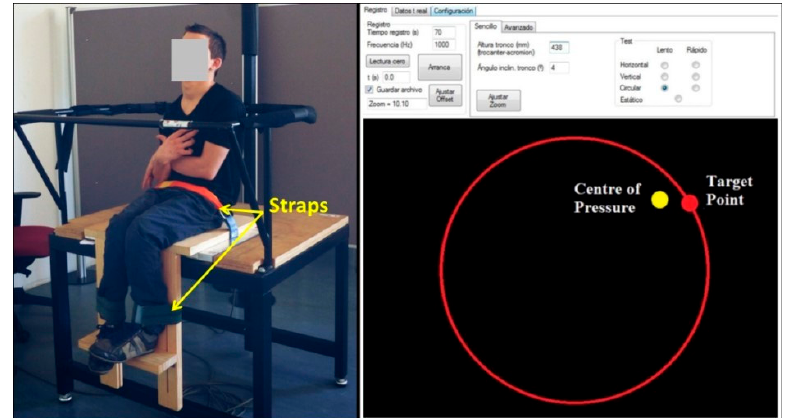
Figure 2. Participants set up on the stable surface ( left ). Screen feedback with the red dot representing